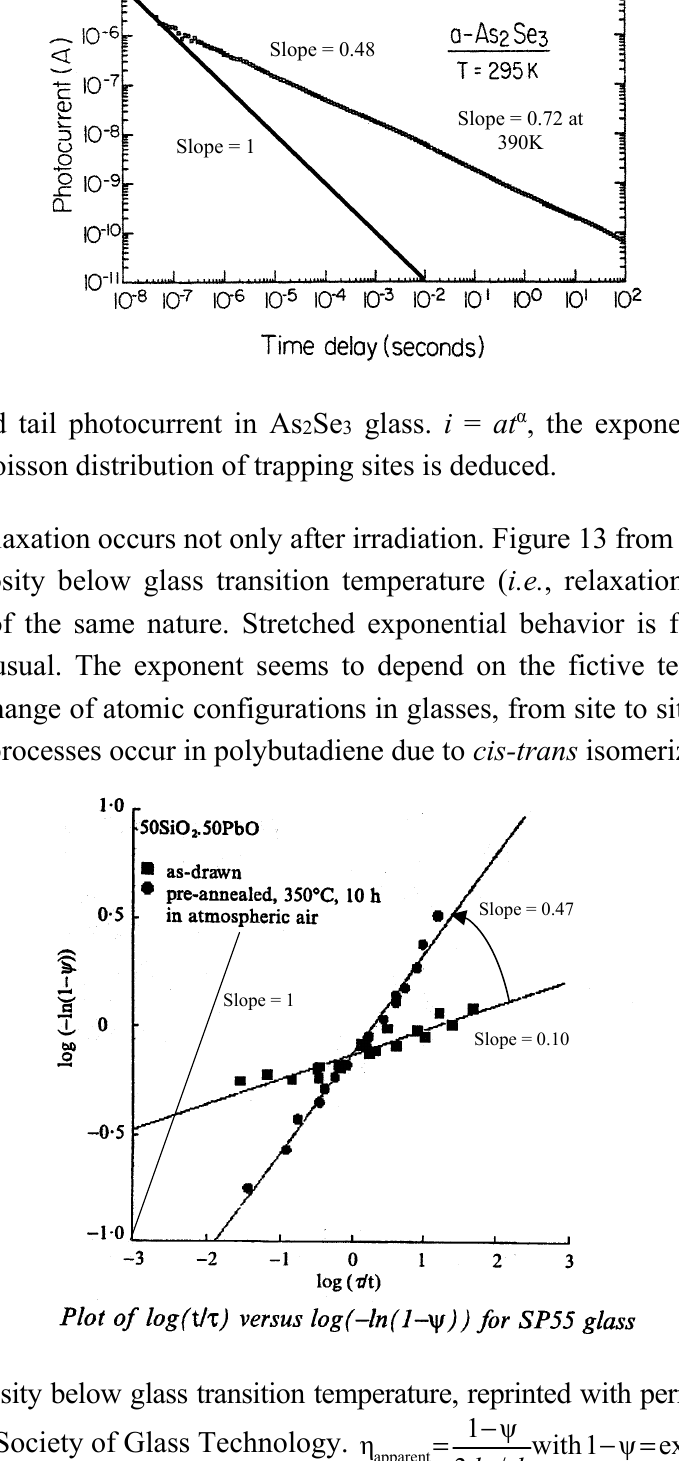
Figure 13. Viscosity below glass transition temperature, reprinted with permission from [23]. Copyright 1997 Society of Glass